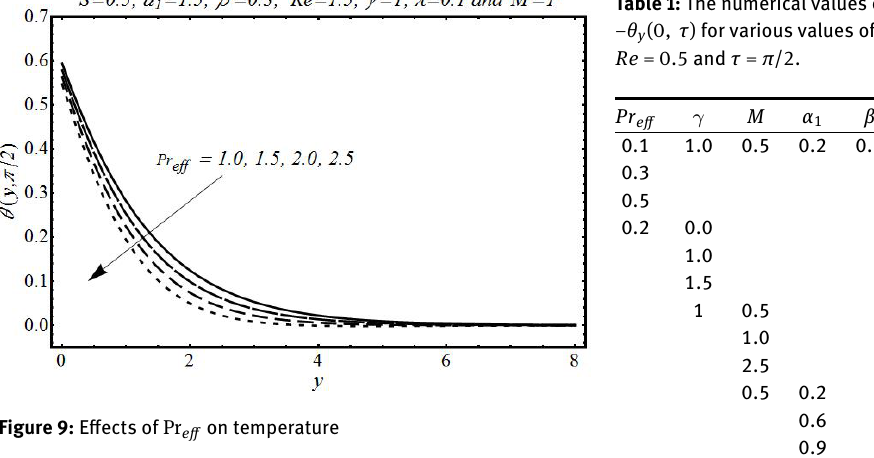
velocity increases with β . The influence of β on f ′ at time instant τ = 10 π is similar to the influence of β on f ′ at the time instant τ = 9 π .